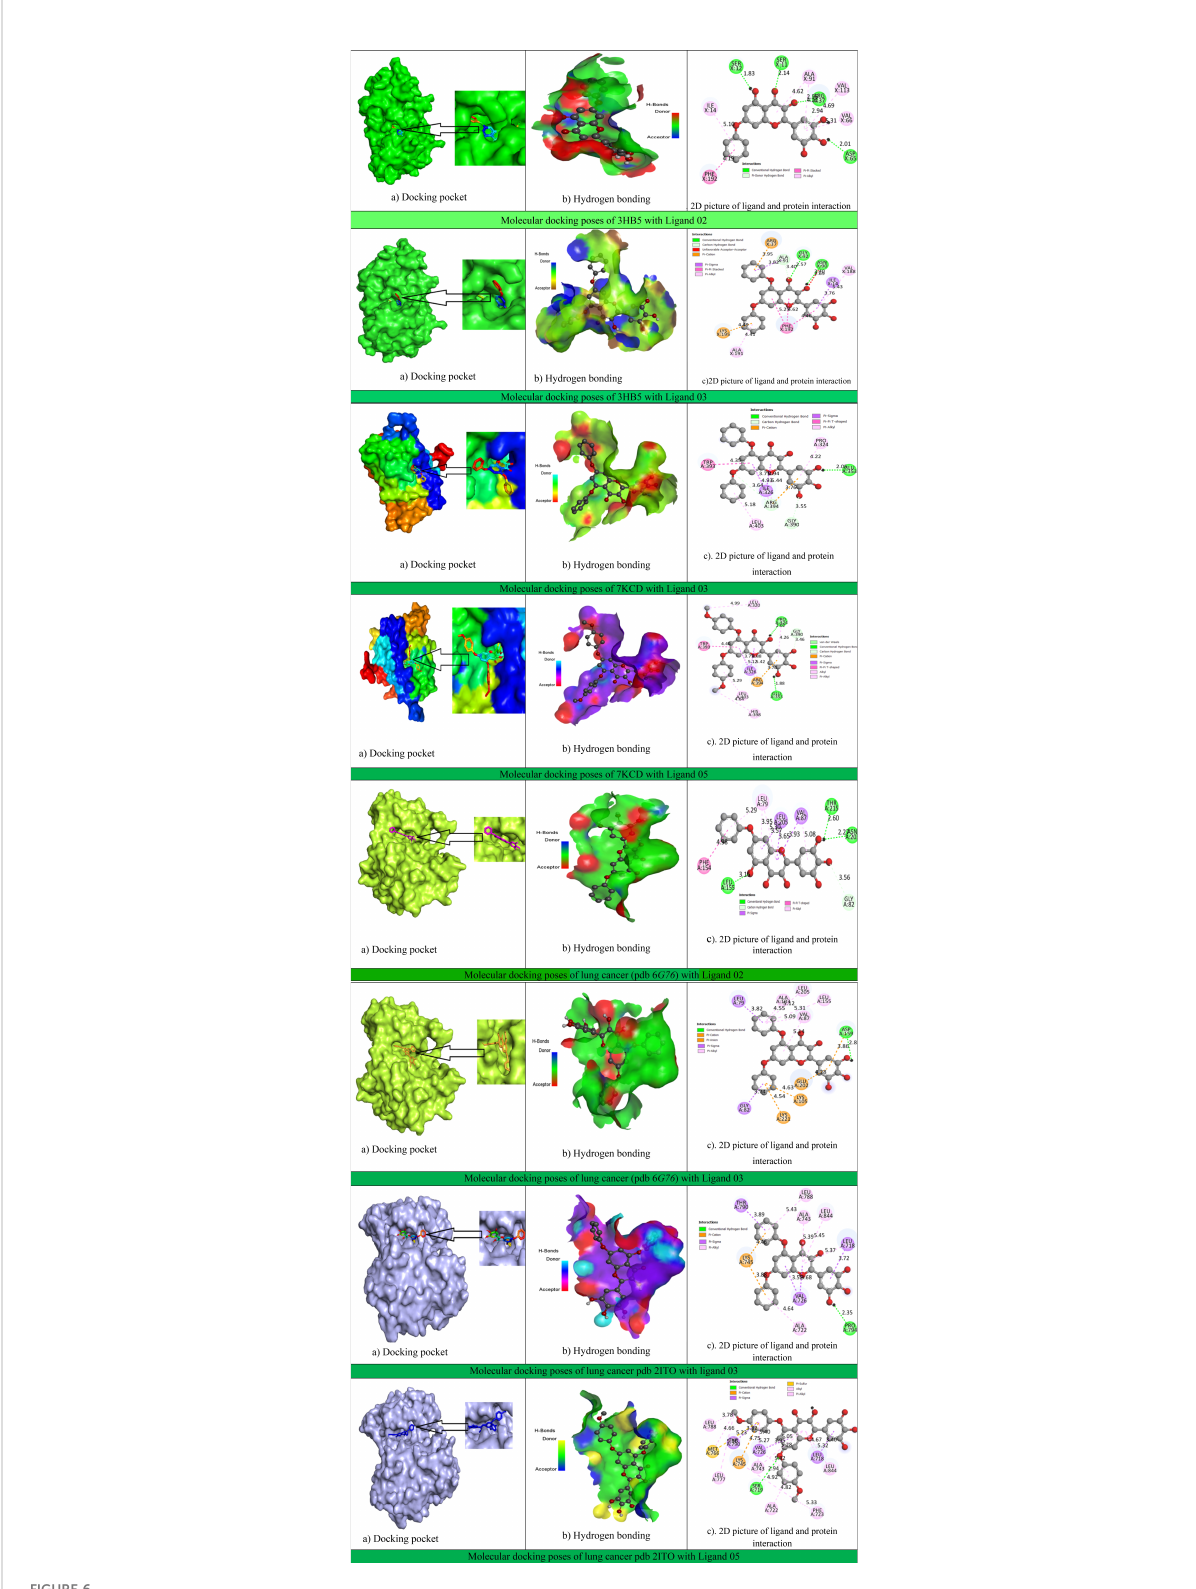
FIGURE 6 Docking interactions between the proposed compound and breast – lung cancer, hydrogen bonding, and 2D picture of the active